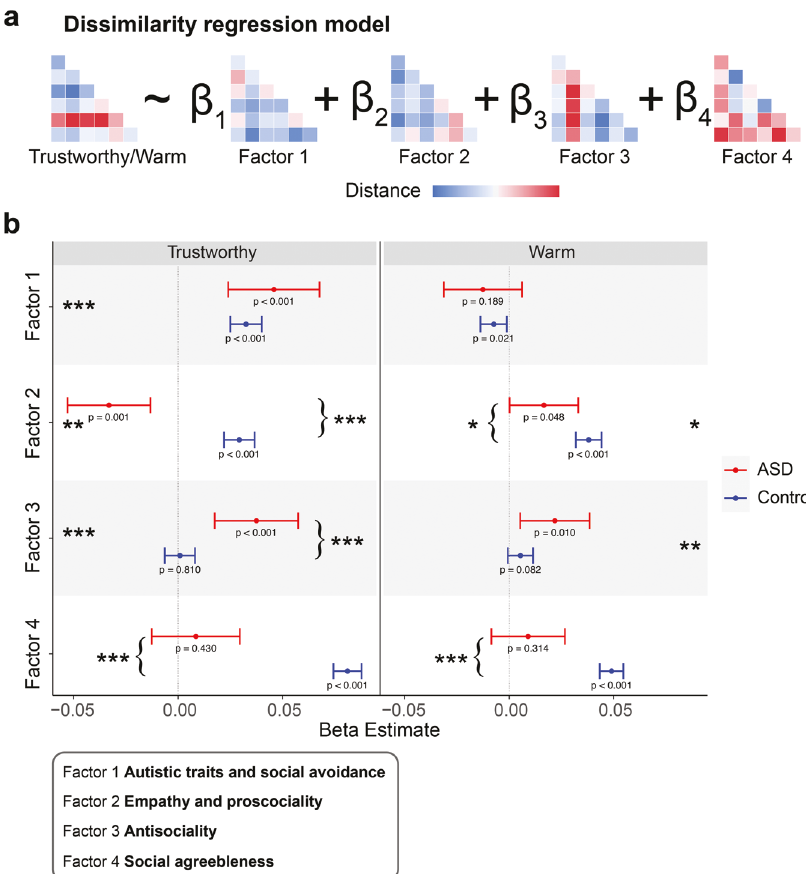
Fig. 6 Results of the representational-similarity analysis. a The structure of the dissimilarity regression model. The dissimilarity matrix structure of the social trait judgments (Trustworthy and Warm) was predicted by the dissimilarity matrices of the four personality dimensions or factors. Each cell represents the Euclidean distance between a pair of participants in the respective social trait judgment or personality dimension. Note that the matrices shown here are for illustration purposes only. b Regression coef fi cients of each personality dimension (factor) for Trustworthy (left) and Warm (right) judgments. The asterisks on the margins indicate signi fi cant main effect of a personality dimension in predicting the social trait judgments, while the asterisks with curly brackets indicate signi fi cant group by factor interaction, or in other words, signi fi cant group difference in the predictive power of a given personality dimension. R code for generating the fi gure was adapted from